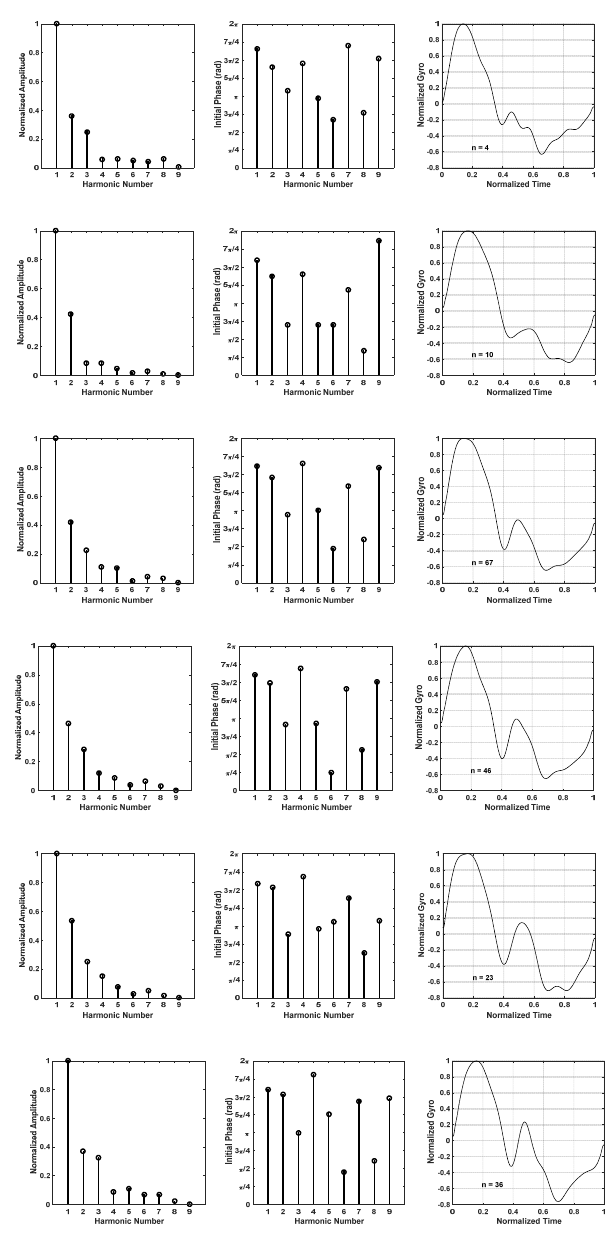
Figure 14. Harmonic models of gyro signal for six commonly observed thigh angle patterns.